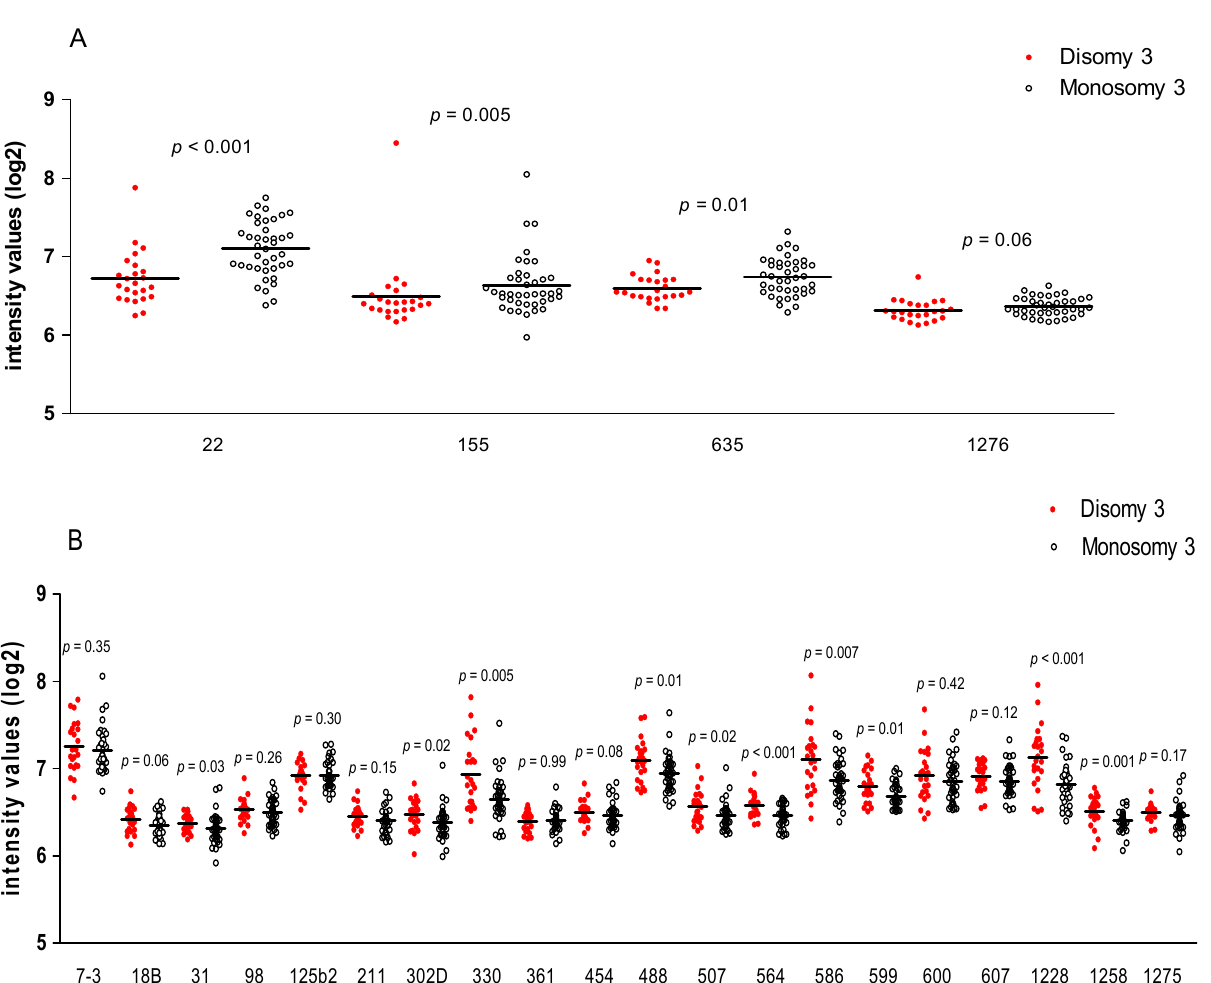
Figure 7. The expression of miRNAs in D3 ( n = 24) and M3 ( n = 40) tumours was compared. MiRNAs that are positively ( A ) or negatively ( B ) associated to HLA Class I are shown. Using a Mann-Whitney U test, p ≤ 0.05 was considered significant. MiRNA name is indicated as numbers. Horizontal bars indicate mean